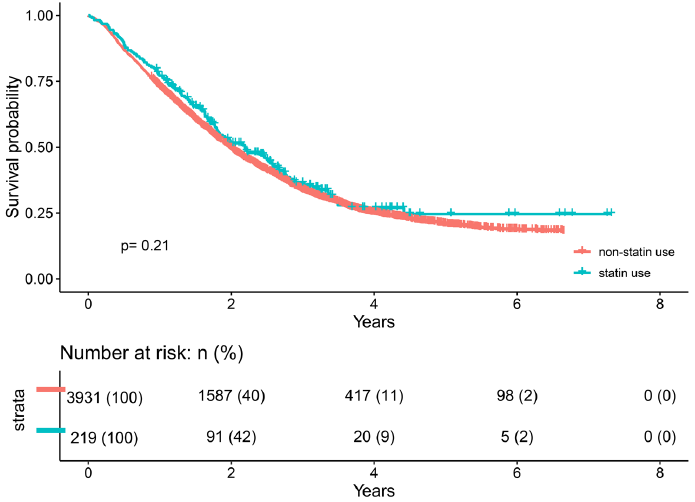
Figure 1. The Kaplan–Meier curve between statin use and overall survival of cancer patients with brain metastasis. Table 1. The clinical demographic characteristics of the brain metastatic cancer patients in the pre- sent study.